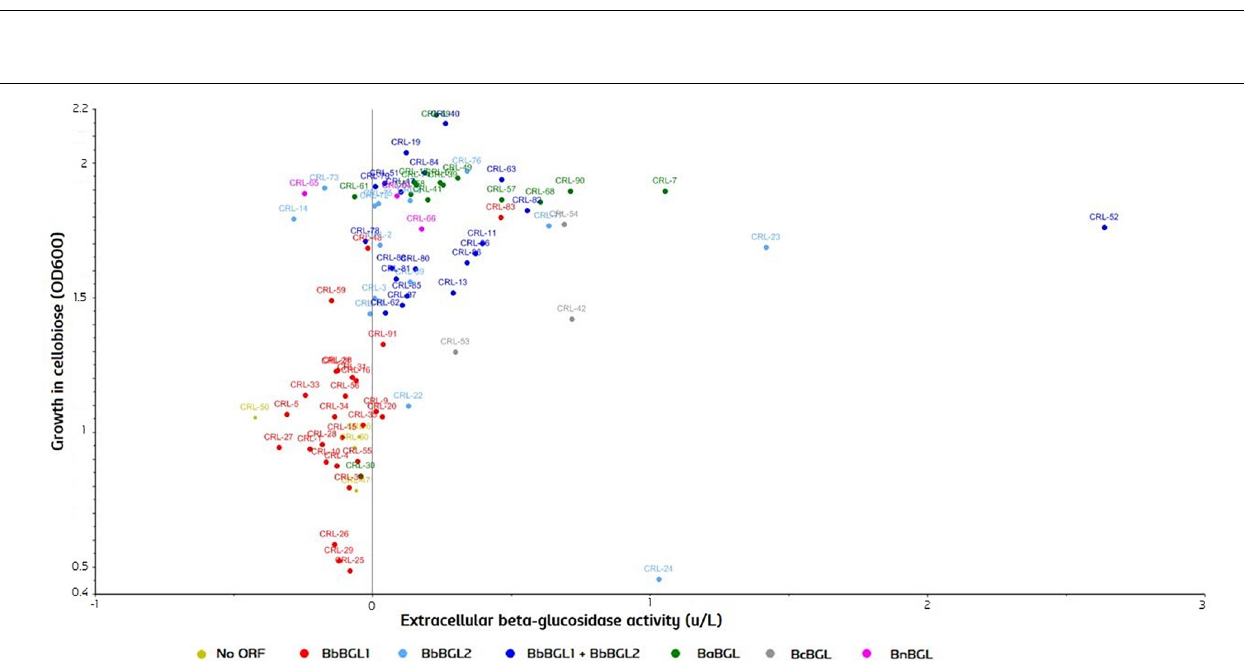
Frontiers in Microbiology |